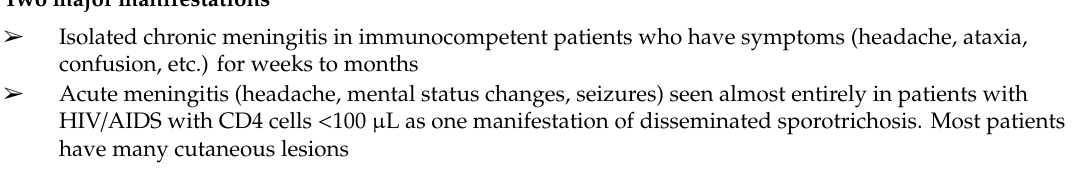
Table 4. Salient Points Regarding Central Nervous System (CNS)